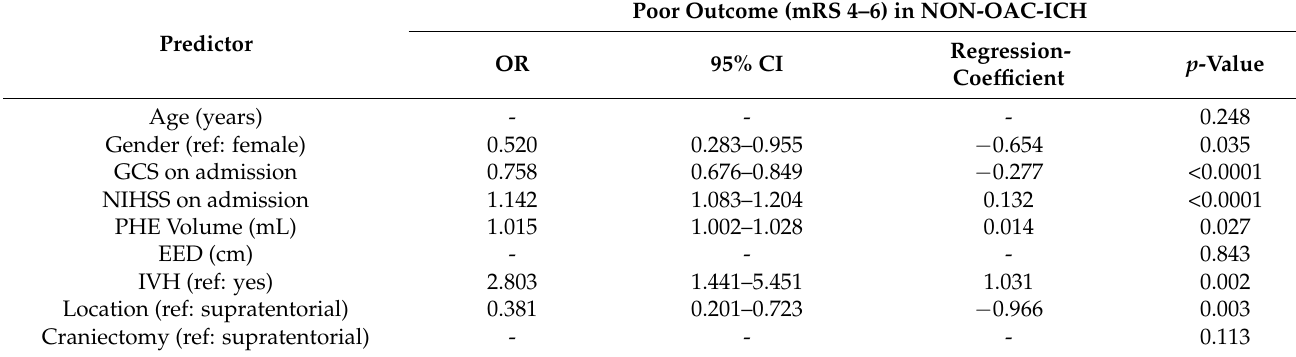
Table 4. Multivariate analysis of predictors of poor outcome (modified Rankin scale 4–6 at 90 days) in patients with non-oral anticoagulation associated intracerebral hemorrhage